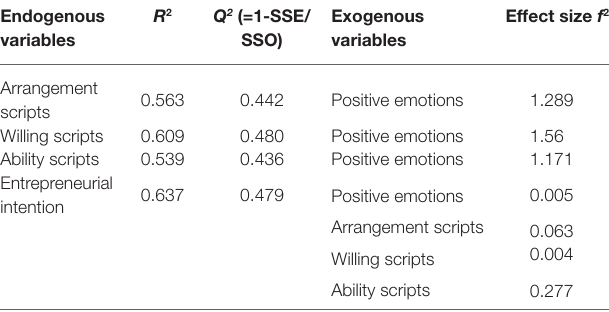
TABLE 10 | Predictive relevance and effect